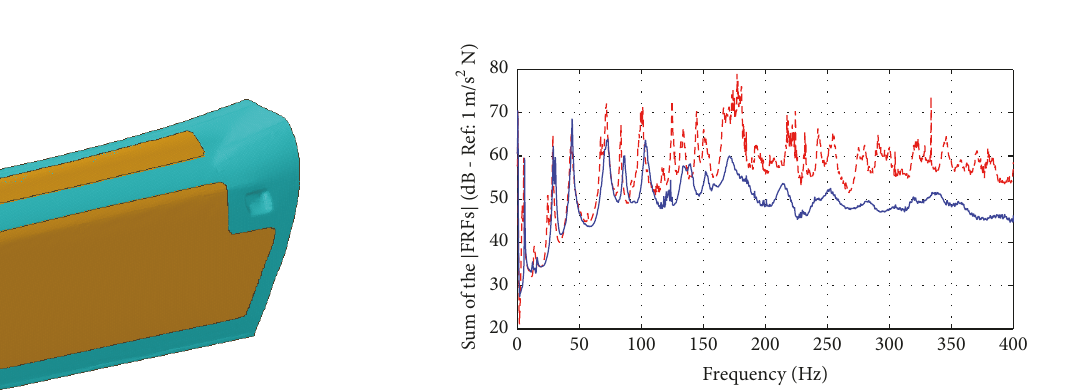
Figure 15: Comparison of the damped and undamped panels: sum of the FRFs: red dashed line: undamped panel-blue solid line: damped